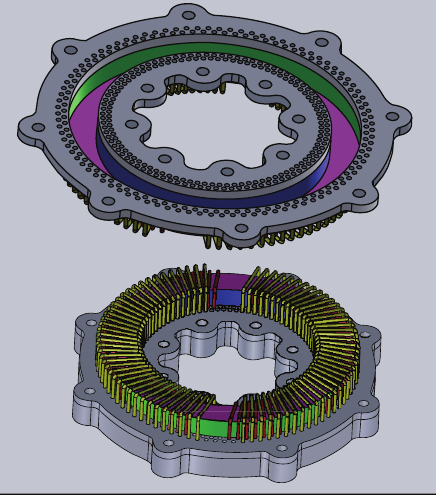
Figure 3: Innovative structure of the new standardized toroidal frame with high